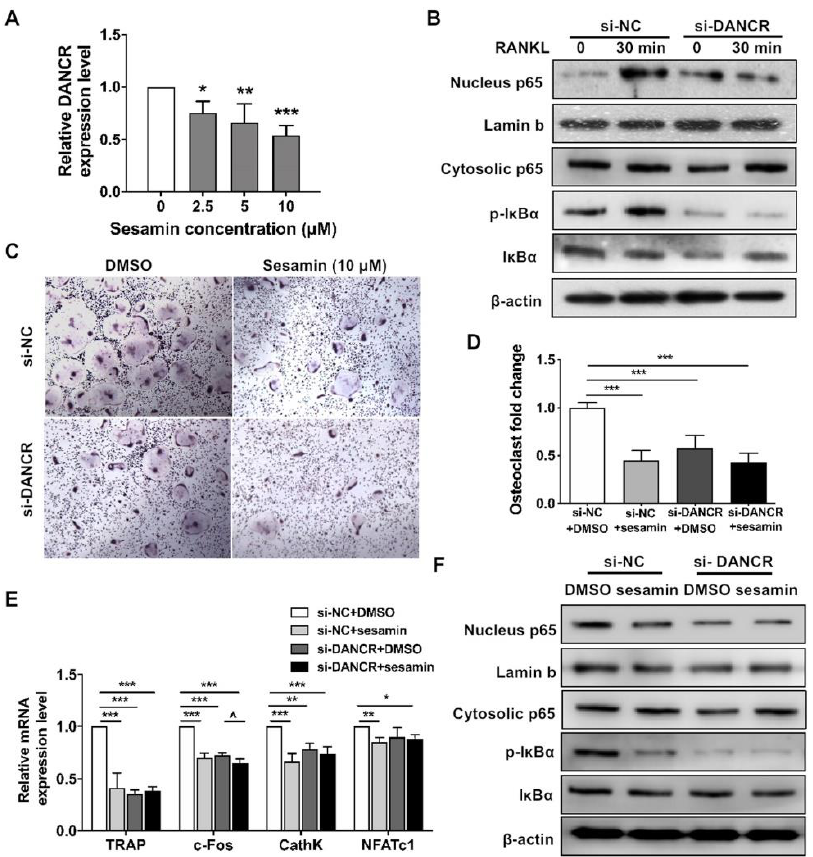
Figure 5. DANCR mediated sesamin-induced osteoclastogenesis of RAW264.7 cells. ( A ) DANCR was downregulated in RAW264.7 cells after treated with sesamin ( n = 6; * p < 0.05, ** p < 0.01, *** p < 0.001). ( B ) Analysis of phosphorylation and non-phosphorylation levels of NF- κB/p65 and IκBα levels by Western blot analysis in RAW264.7 cells after DANCR siRNA knockdown and treated with RANKL for 30 min. ( C ) . RAW264.7 cells were DANCR knockdown and the TRAP staining assay was performed at Day 5 after RANKL-induced osteoclastogenesis. ( D ) Quantitative data of osteoclast fold change ( n = 6; *** p < 0.001). ( E ) The mRNA expression level of osteoclastogenic differentiation related markers measured by real-time PCR ( n = 6; * p < 0.05, ** p < 0.01, *** p < 0.001, versus si- NC + DMSO group; ^ p < 0.05, versus si-DANCR + DMSO group). ( F ) Analysis of NF- κB/p65 nucleus translocation and IκBα phosp horylation levels by Western blot analysis in RAW264.7 cells with/without DANCR knockdown after cells were treated with sesamin for 24 h and treated with RANKL for 30 min.